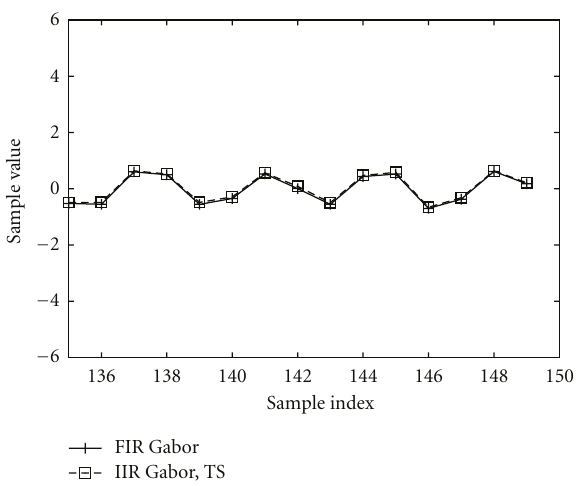
Figure 4: The forward-backward transition for the direct Gabor fil- tering initiates correctly when compared to an FIR implementation. Compare it with Figure 2. Only real parts of the complex filtering results are shown here.